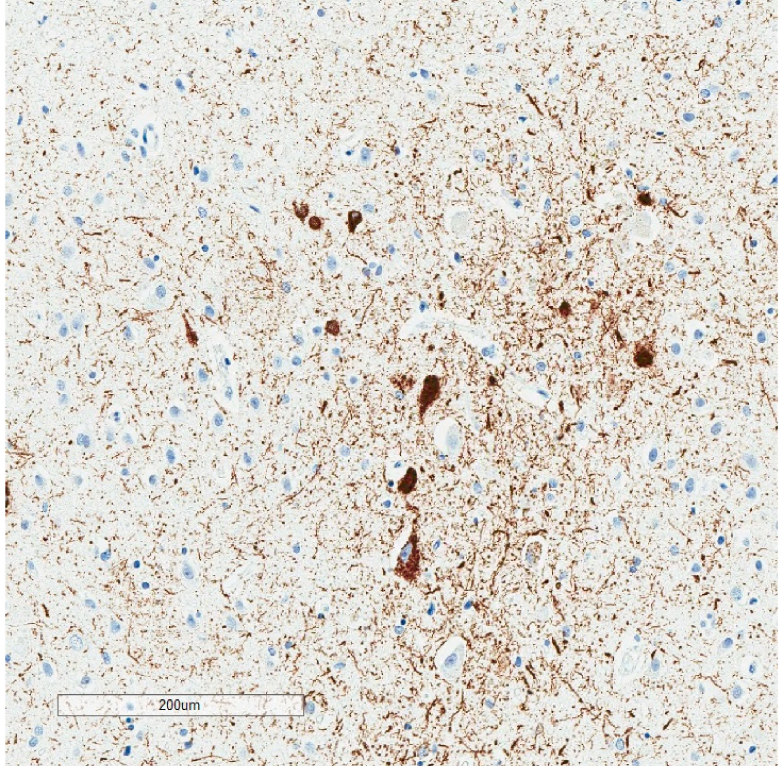
Figure 5. Selective labeling of the pre-alpha neurons of the entorhinal cortex by p-tau (AT8) immunohistochemistry, highlighting selective